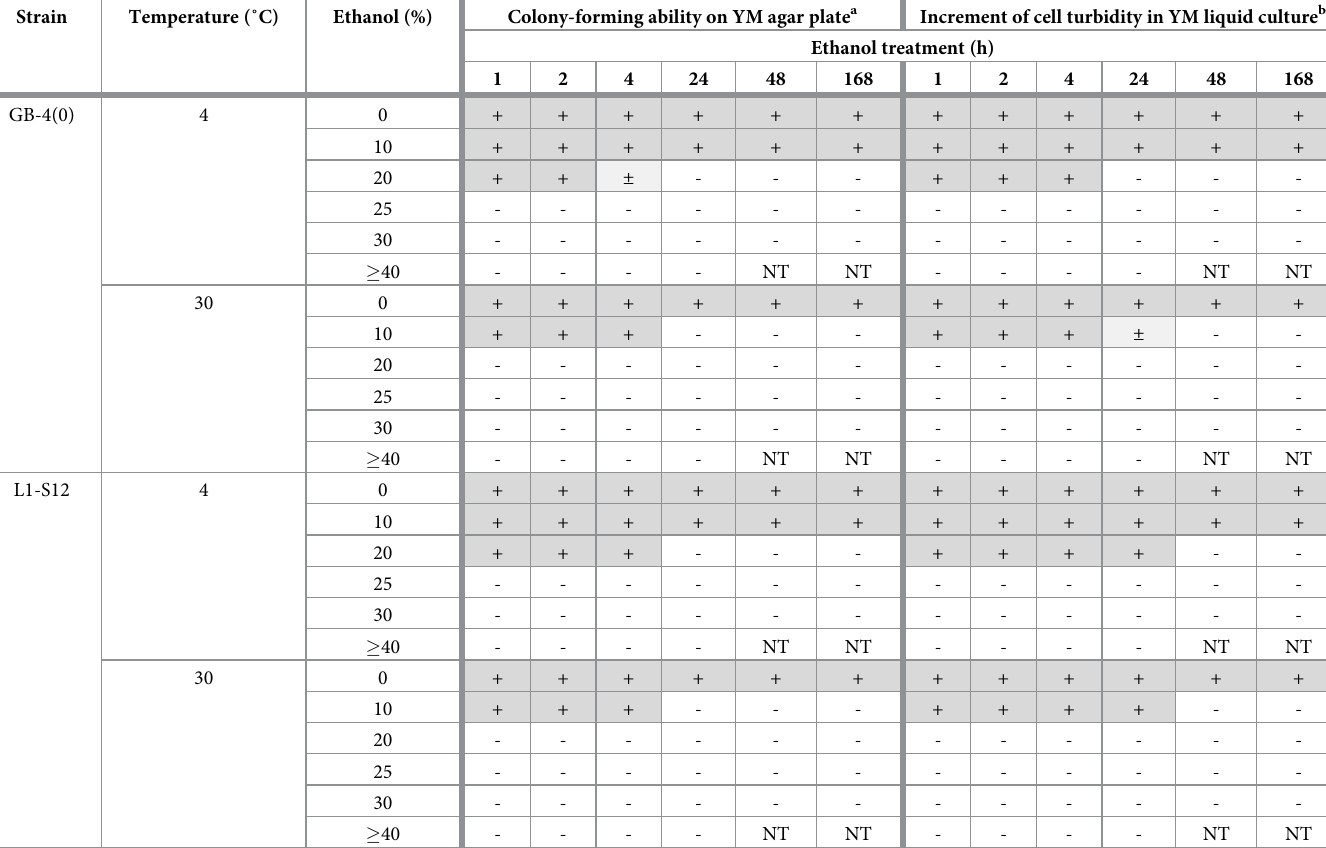
After treating the culture filtrate of P . antarctica L1-S12 with various concentrations of ethanol, no precipitates were obtained in 0% or 25% (v/v) ethanol. Each precipitate obtained in 50%, 70%, and 90% (v/v) ethanol was dissolved in DDW, and the remaining enzyme was measured (Table 2). Only a small portion of PBSA-degrading activity precipitated in 50% or 70% (v/v) eth- anol, whereas the entire activity was recovered in the precipitate generated in 90% (v/v) ethanol. The precipitate generated in 90% (v/v) ethanol solution prepared from the supernatant of the 70% (v/v) ethanol solution recovered nearly 90% of the activity in the original culture filtrate, and its specific activity rose to about 2.94-fold that of the original culture filtrate. Table 1. Survival of Pseudozyma antarctica cells after ethanol treatment. Strain Temperature (˚C) Ethanol (%) Colony-forming ability on YM agar plate a Increment of cell turbidity in YM liquid culture b